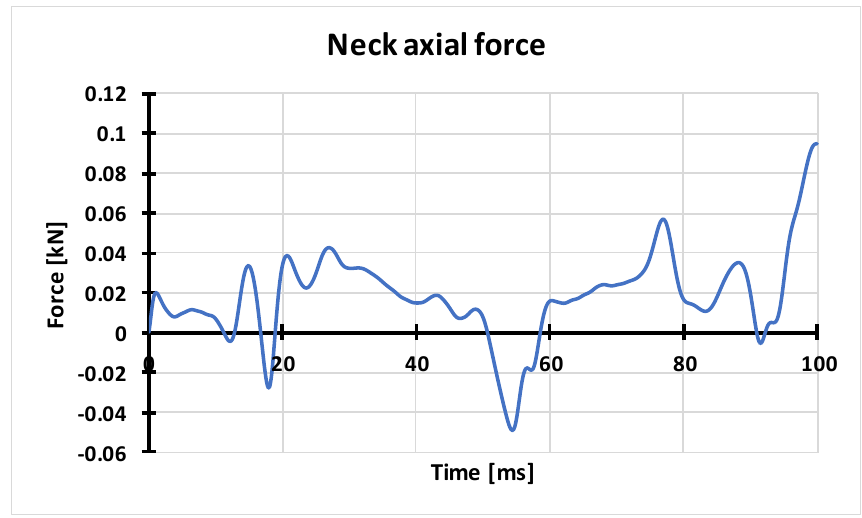
Figure 10. Characteristic of axial force in the dummy’s neck obtained on the basis of numerical calculations.